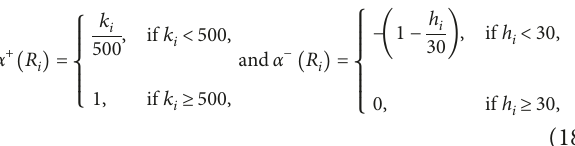
Figure 6: Scattered chart marked with lines depending on BF- closeness and closeness centrality measures (normalized) on G-S Research network.